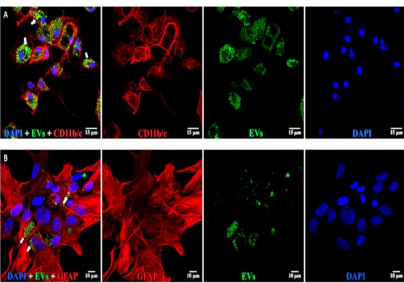
Figure 8. EVs in microglia and astrocytes. ( A , top) Microglia: left to right: composite, anti-CD11b/c (red), EVs (green), and DAPI (blue). EVs are concentrated in large vesicles (arrows) in the cytoplasm. ( B , bottom) Astrocytes: left to right: composite, anti-GFAP (red), EVs (green), and DAPI (blue). EVs are small vesicles (arrows) in the cytoplasm. Scale bars (10 µ m) are on the bottom right of each panel 63 × .